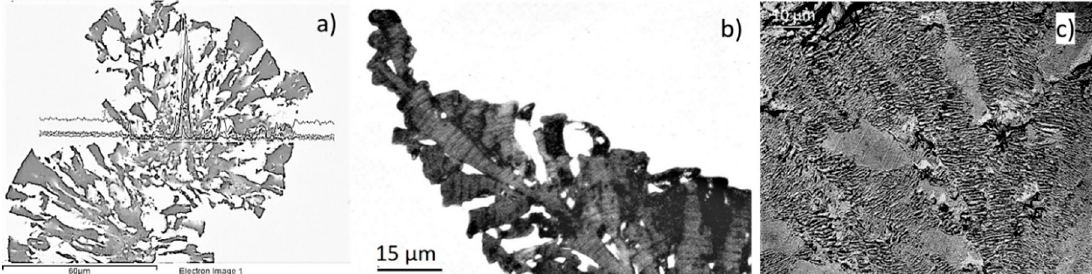
Figure 37. Dendritic graphite in Mg or Ce-treated irons: ( a ) SEM image from a 0.01% Sb CG iron showing dendritic growth of graphite and an EDX pick for Sb in the center, reproduced from [41] with permission from Springer; ( b ) graphite dendrite; cathodic etching in a slow-cooled cerium-treated melt, reproduced from [131] with permission from JIM; ( c ) TEM image from the dendrite in ( b ), reproduced from [131] with permission from JIM.